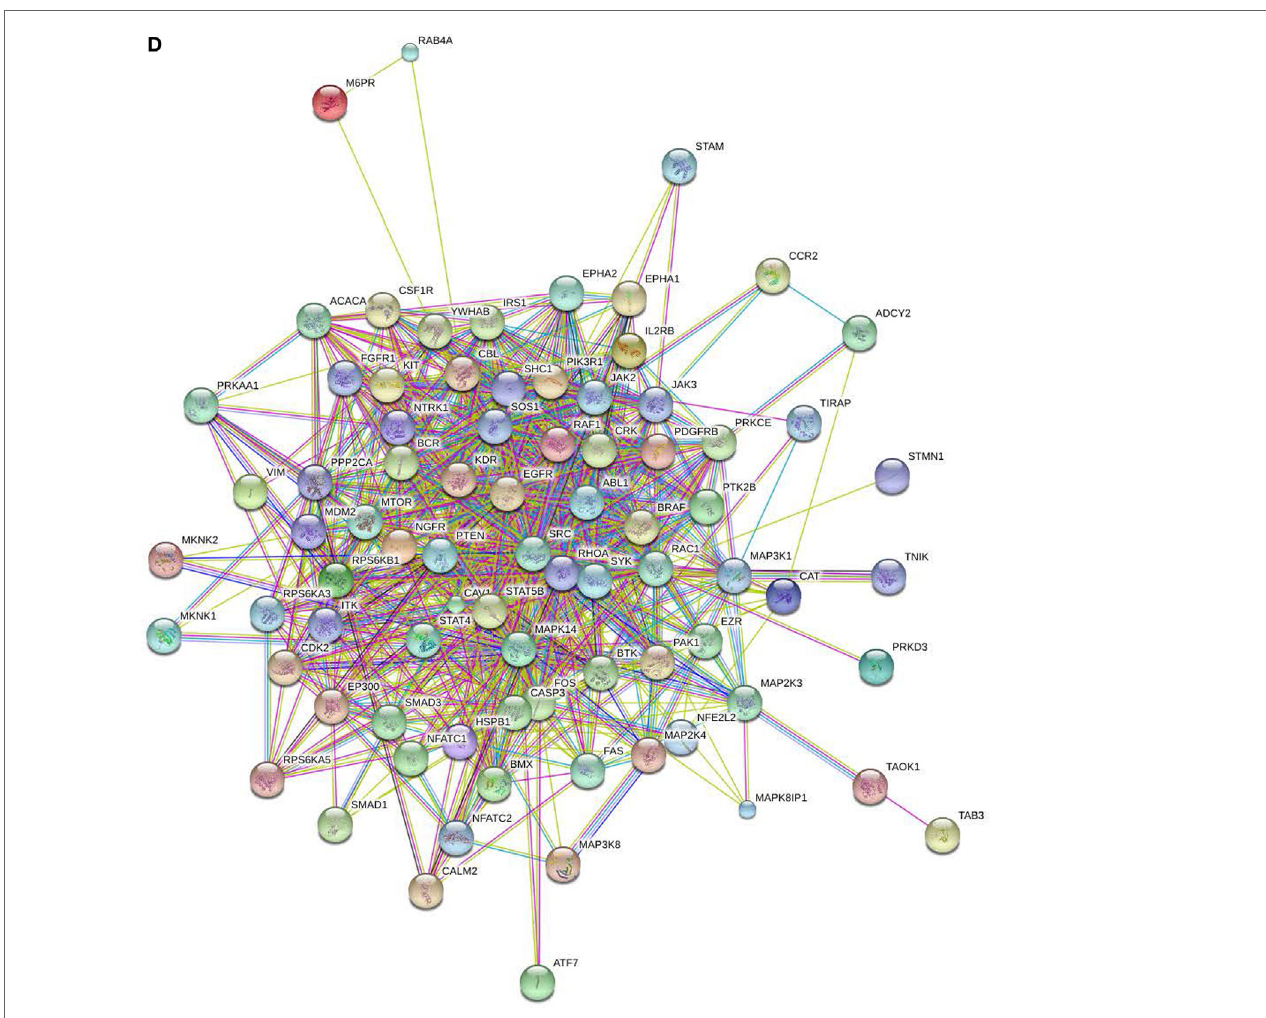
FigUre 2 | Protein–protein interactions. Predicted protein–protein interactions generated following analysis of significantly different peptides input into the STRING database: (D) middle high interactions.